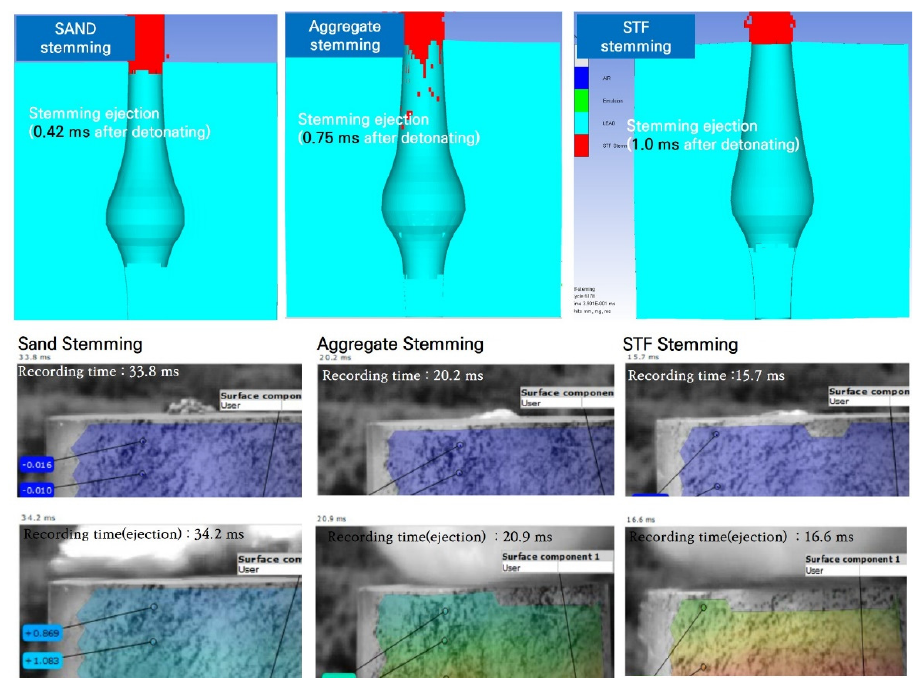
Figure 19. Stemming material ejection on the blast hole after